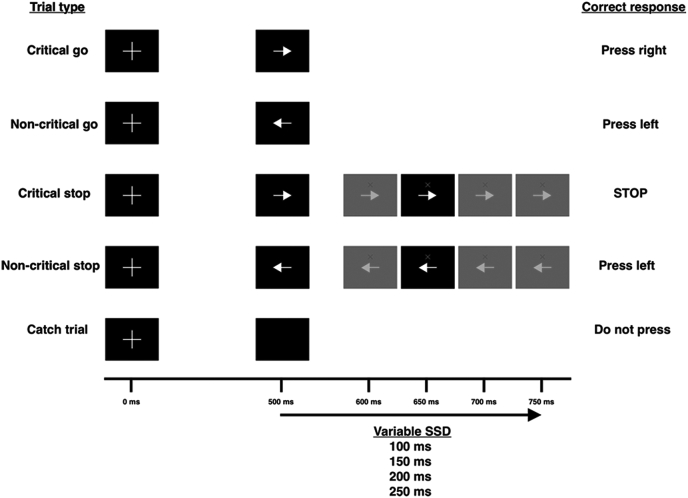
The Conditional stop-signal task (CSST).The different trial types on the CSST with their appropriate responses (critical direction is right). All stimuli stay on the screen until the next stimulus appears. The stop signal delay (SSD) changes between one of four values depending on the performance of the previous critical stop trial.